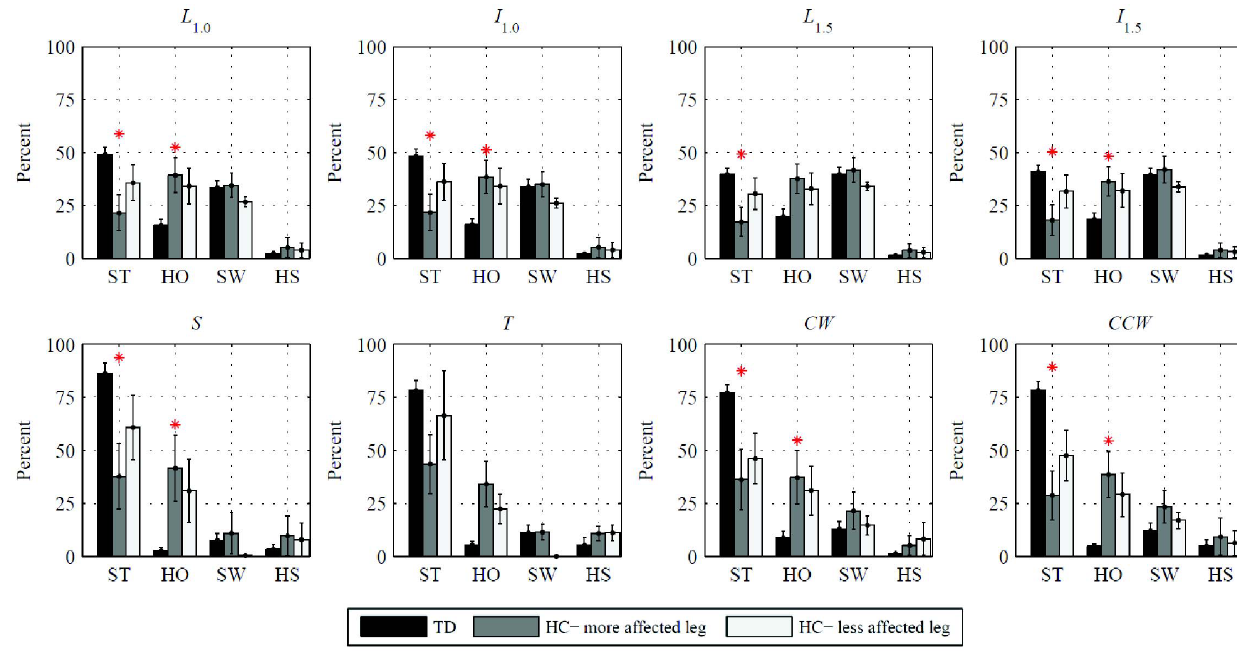
Figure 3. Percent time spent in each gait phase by typically developing children and children with hemiplegia. The three populations are the combined legs of typically developing children (TD), the more affected legs of the children with hemiplegia (HC), and the less affected legs of the children with hemiplegia. Results are given as mean 6 one standard error over each population, detected by A OL . For patients with equally affected sides, the right is taken as the more affected leg. Gait phases in which the three populations spend statistically significant different times are starred (ANOVA, p , 0.05). doi:10.1371/journal.pone.0073152.g003 sensitivity are greater than or equal to 0.95 for walking tasks averaged over each health status and are greater than 0.92 for